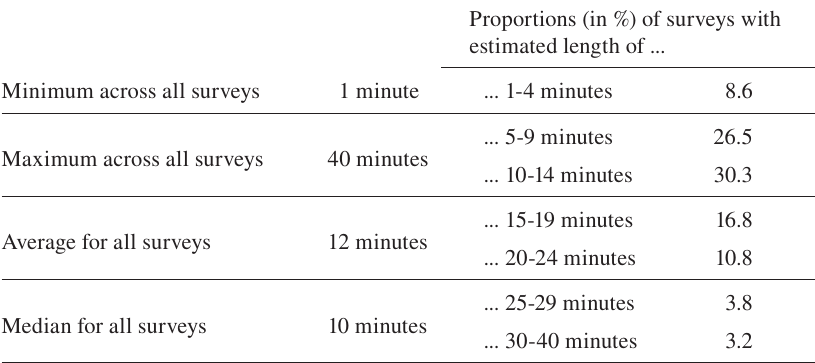
Estimated length of the surveys in minutes